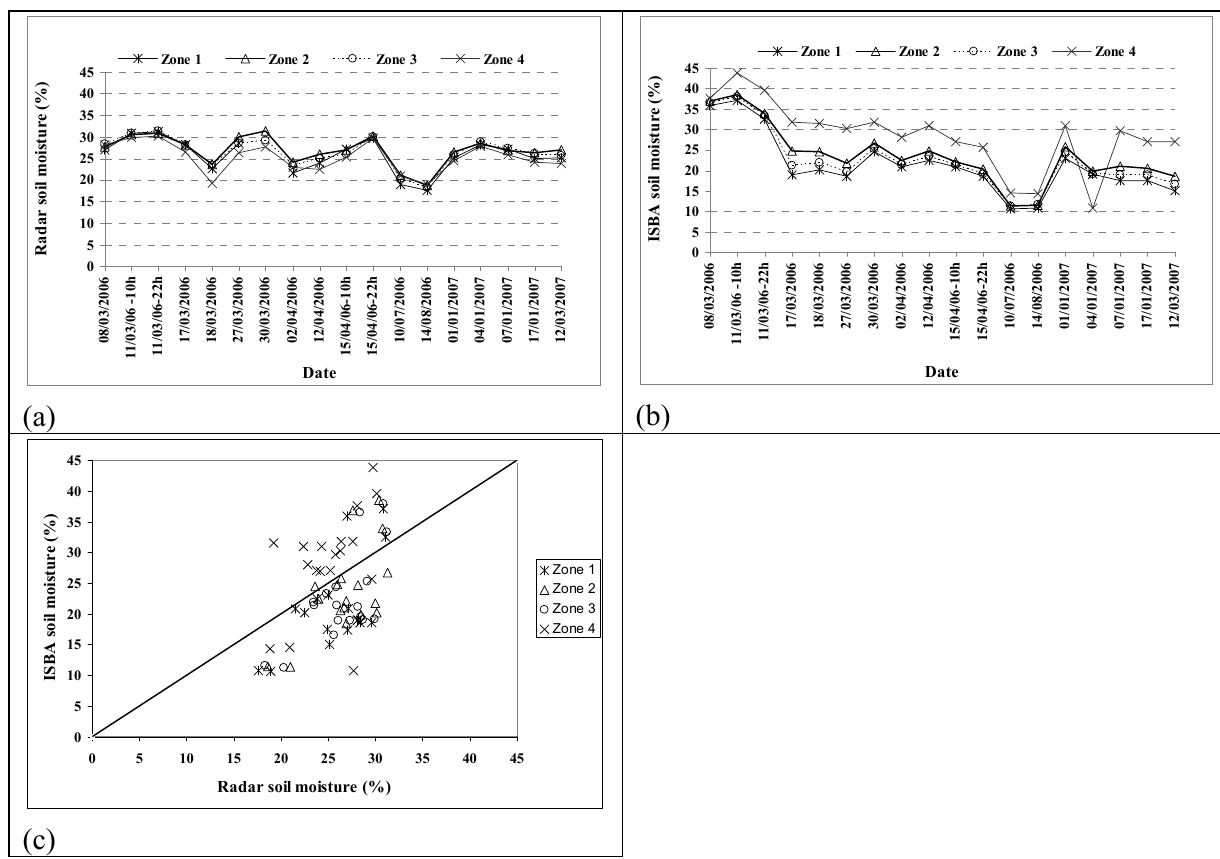
Figure 8. Correlation between textural zones and surface soil moisture simulated from ISBA model, and estimated from ASAR images. Each symbol corresponds to the mean soil moisture on each textural zone. Zone 1 is mainly sandy and zone 2 is mainly composed of clay (cf. Figure